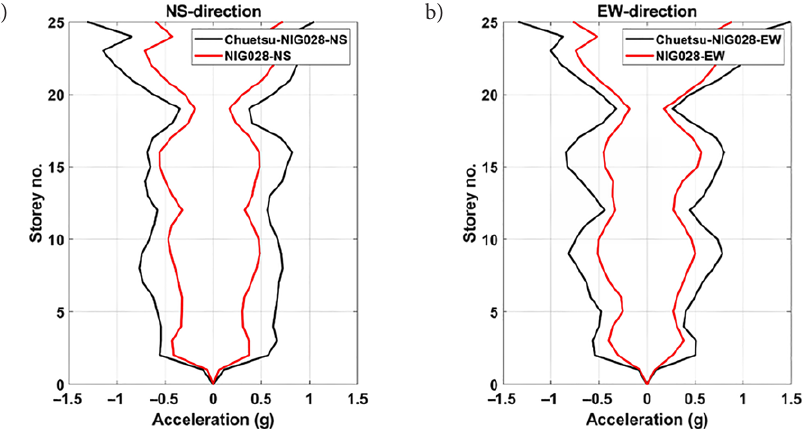
Figure 7. Peak story acceleration curves of the high-rise building vs. story number under the NS and EW components of the Niigata records with and without sequences in the: a – transverse direction and b – longitudinal direction